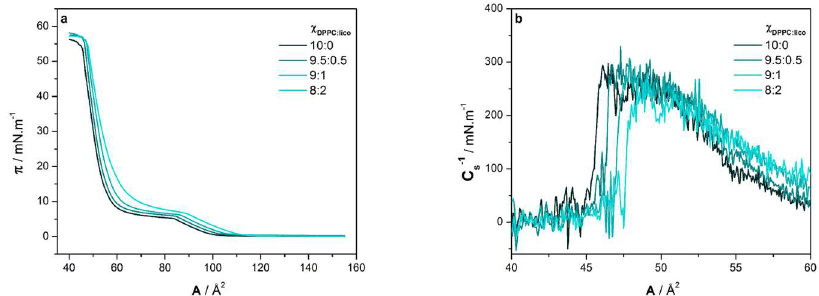
Figure 2. ( a ) Surface pressure-area per lipid molecule ( π -A) isotherms of various DPPC:licofelone molar fractions (X DPPC:lico ) at pH 7.4; ( b ) Maximum compressibility modulus (C s − 1 ) vs area per lipid molecule (A) plot calculated from the obtained π -A isotherms.